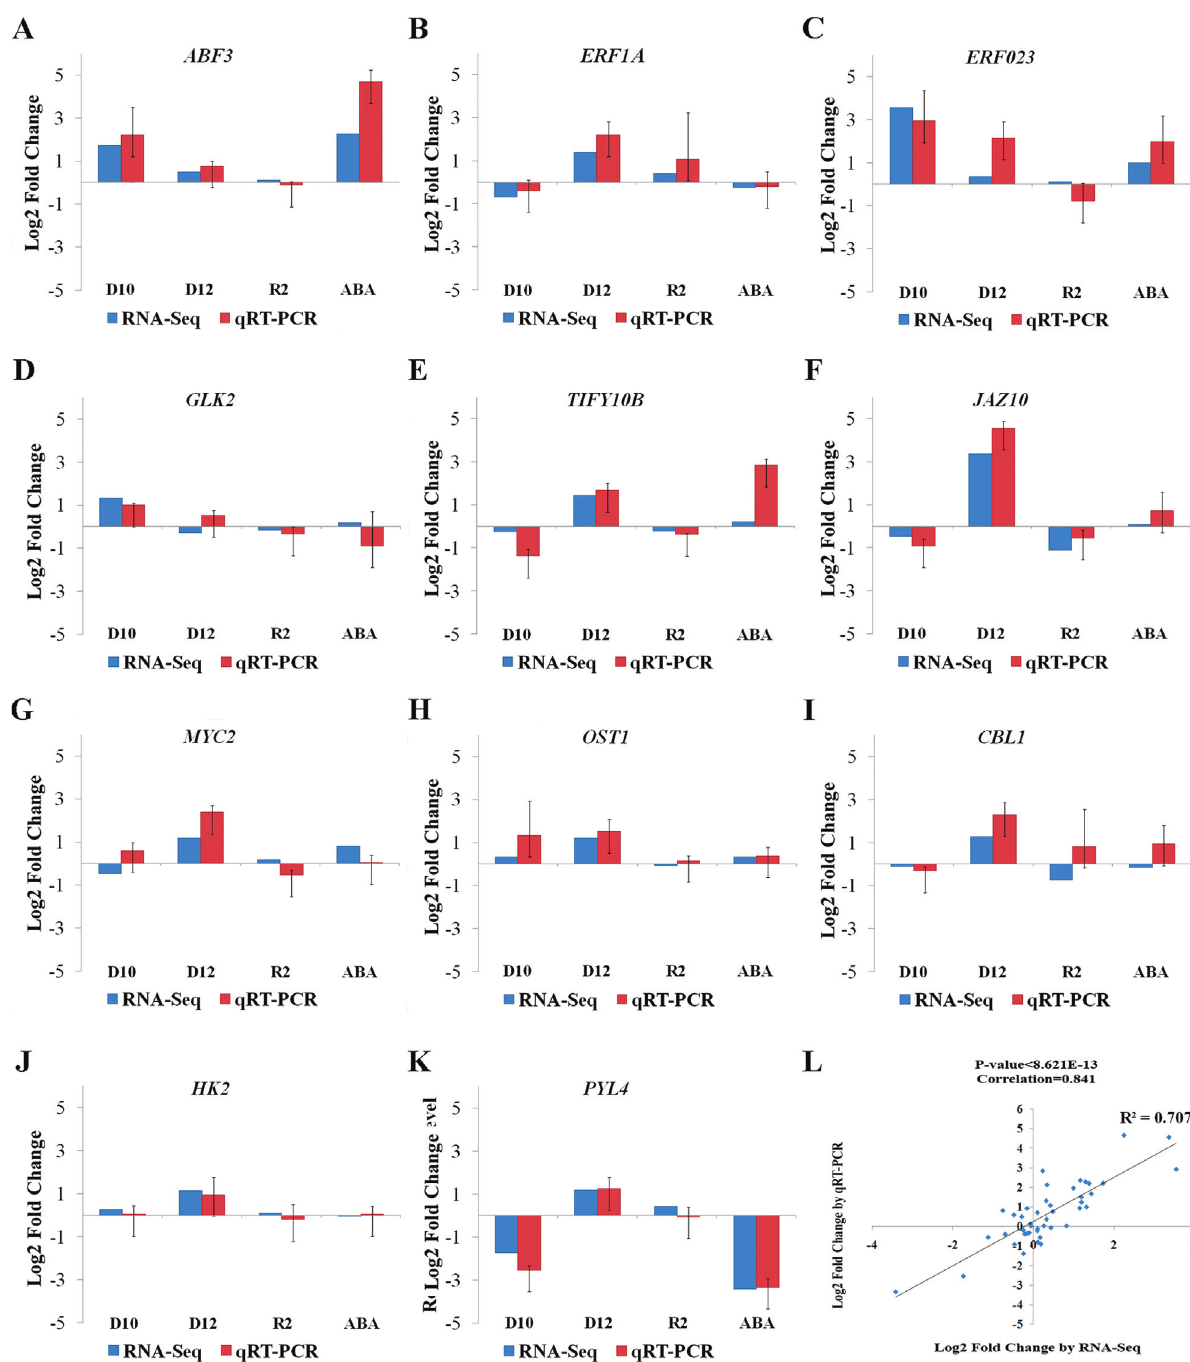
Figure 3 - Quantitative RT-PCR validations of differentially expressed genes in four situations. (A) to (K) are the genes ABF3 (AT4G34000) , GLK2 (AT5G44190) , ERF023 (AT1G01250) , ERF1A (AT3G23240) , MYC2 (AT1G32640) , HK2 (AT5G35750) , CBL1 (AT4G17615) , OST1 (AT4G33950) , PYL4 (AT2G38310) , JAZ10 (AT5G13220) and TIFY10B (AT1G74950) , respectively. The data are presented as the log 2 value of the fold change from RT-qPCR and RNA-Seq. D10, D12, R2 and ABA represent plants under drought stress for 10 days, 12 days, rewatered for 2 days, and sprayed with 10 (cid:2) mol/LABAfor4hours,respectively.Errorbarsrepresentthemean (cid:6) SDofthreebiologicalreplicates.(L)Pearsoncorrelationanalysisbetweenthere- sults of the two methods was performed, and a scatter plot was